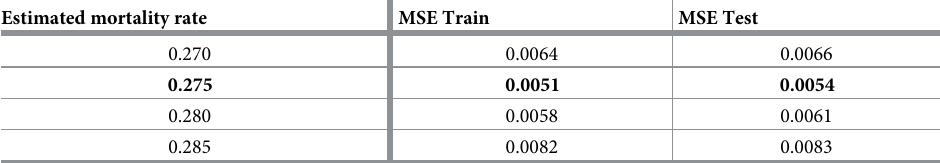
Table 11. The MSE value of ANN-BTA network after interval limiting [1,1.2] and obtaining the lowest error rate in estimating mortality rate. Estimated mortality rate MSE Train MSE Test